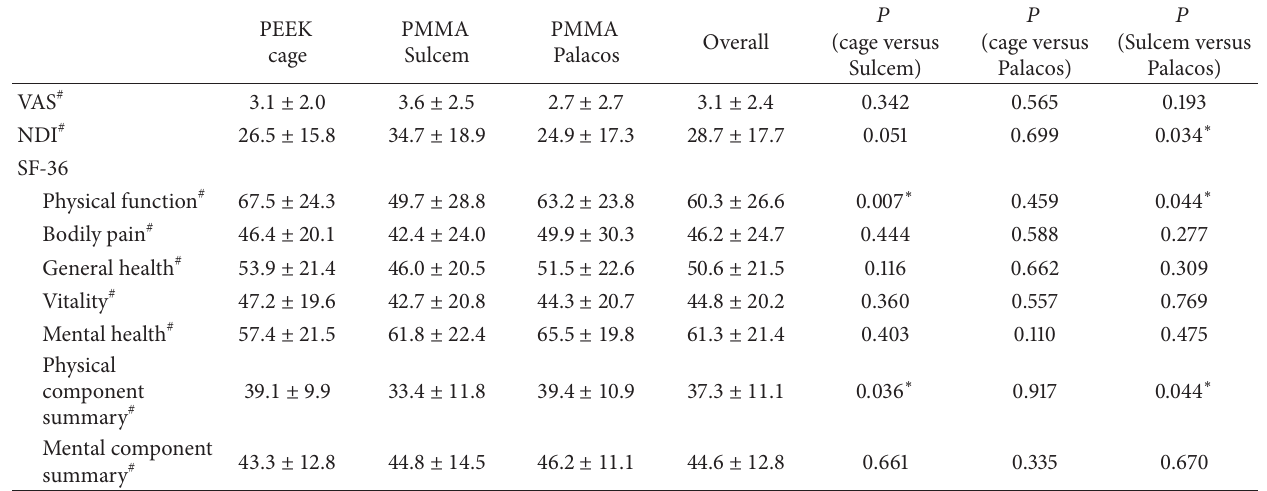
Table 3: Clinical